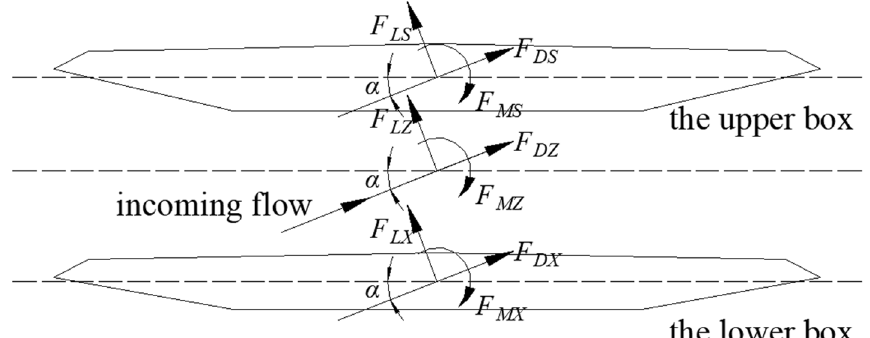
Fig. 4 Definitions of the aerodynamic